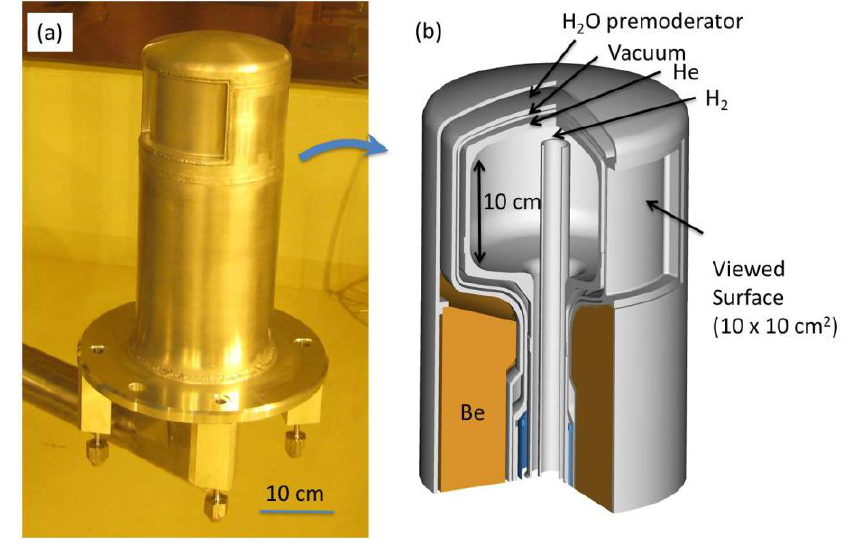
Figure 10. ( a ) Photograph of coupled moderator. ( b ) Cutaway view of coupled moderator.